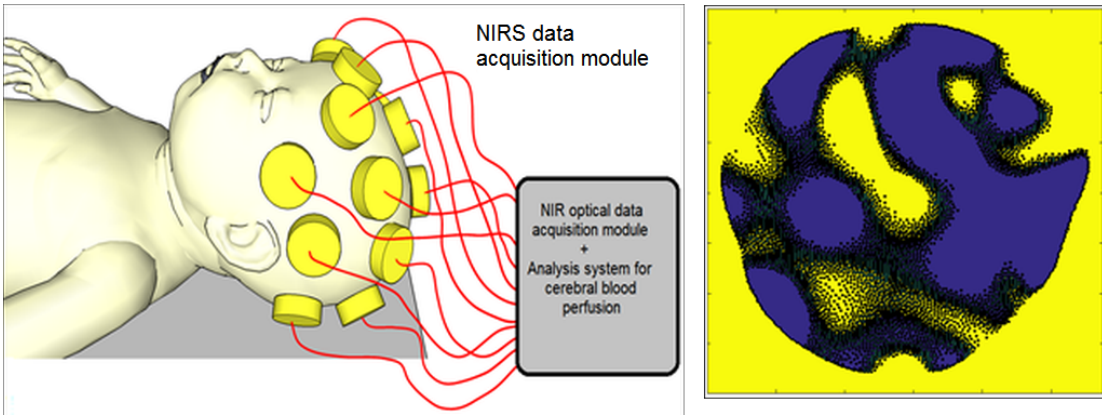
Figure 6. ( Left ) Diagram of neonatal NIR spectroscopy (NIRS) imaging. A series of photo-emitting diodes and photo-width = 0.9 are integrated to acquire NIRS data from multiple areas of the neonate’s head to reflect blood perfusion in the cerebral cortex. ( Right ) 2D reconstruction of NIRS images of a neonatal